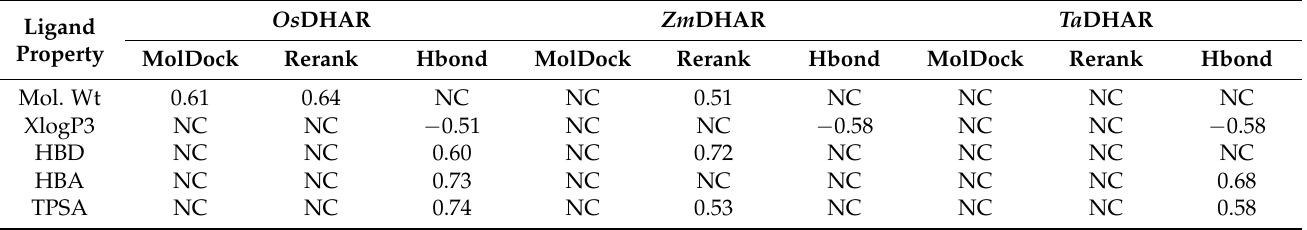
Figure 5. Energy maps of the receptors showing favourable surfaces for different types of interactions. The docked poses of the ligands including metabolites and ions are also shown. Table 4. Correlation analysis of docking scores of the DHAR of rice, maize and wheat with different ligand properties. NC: Not